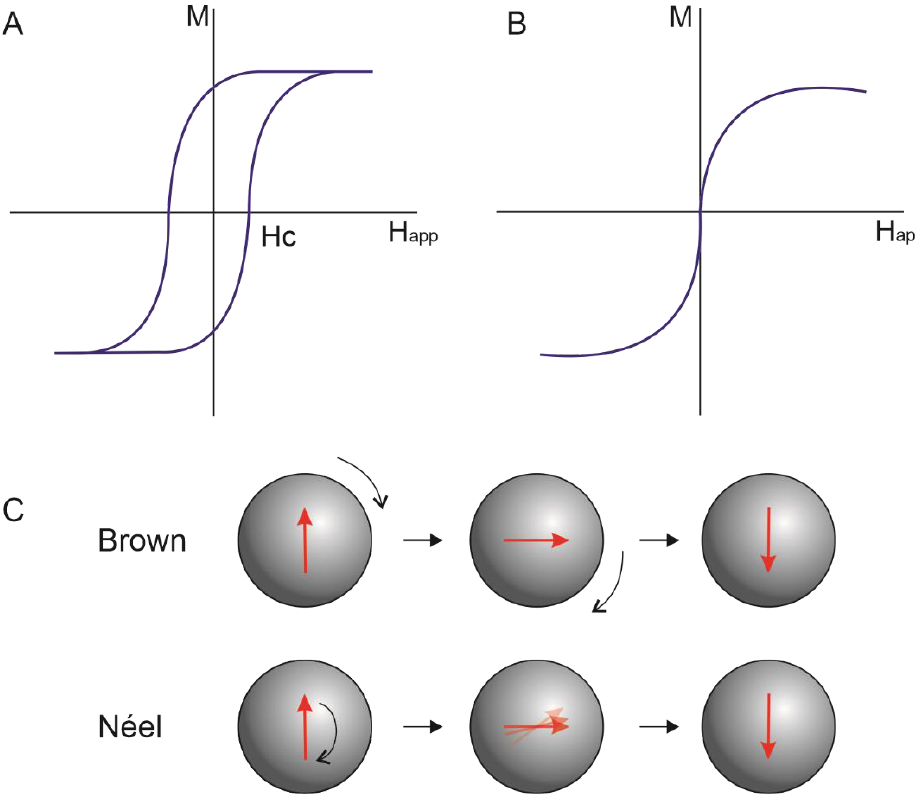
Figure 2. The magnetization curve of ( A ): multidomain structure and ( B ): superparamagnetic nano- particles. ( C ): Néel and Brown relaxation of magnetic nanoparticles. nanoparticles. ( C ): N é el and Brown relaxation of magnetic